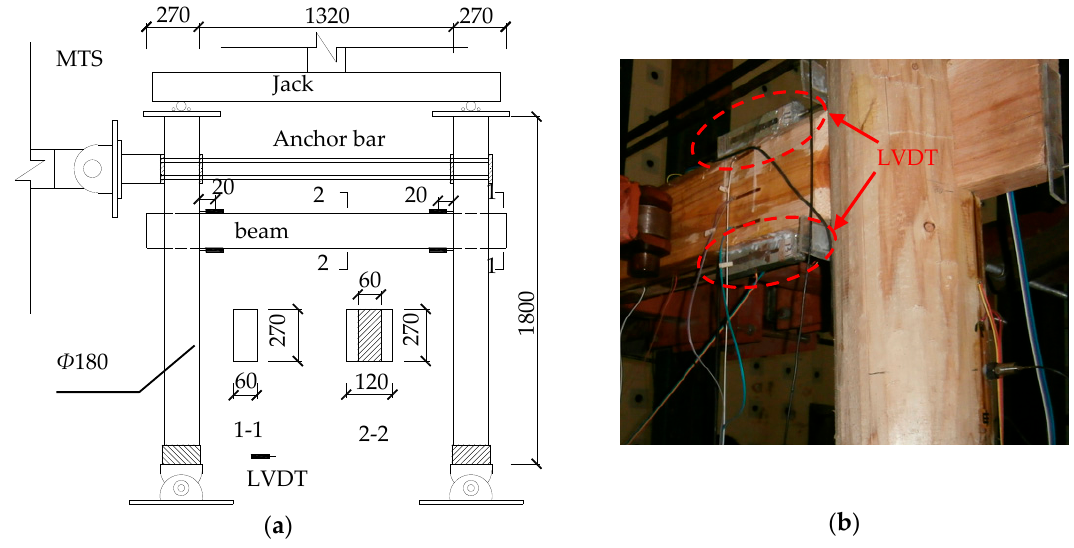
Figure 15. Test setup and sensor layout: ( a ) Timber frame loading setup; ( b ) LVDT layout.